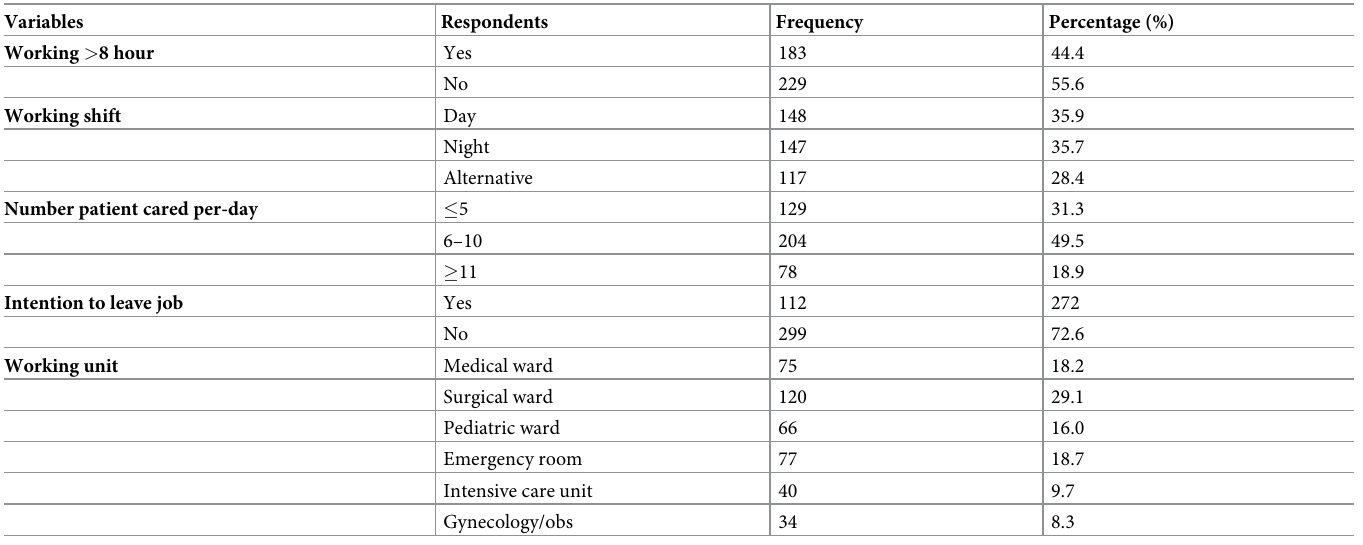
Table 2. Work/job characteristics of nurses who were working in public hospitals of Harari regional state and Dire Dawa administration, Ethiopia, 2020 (n = 412). Variables